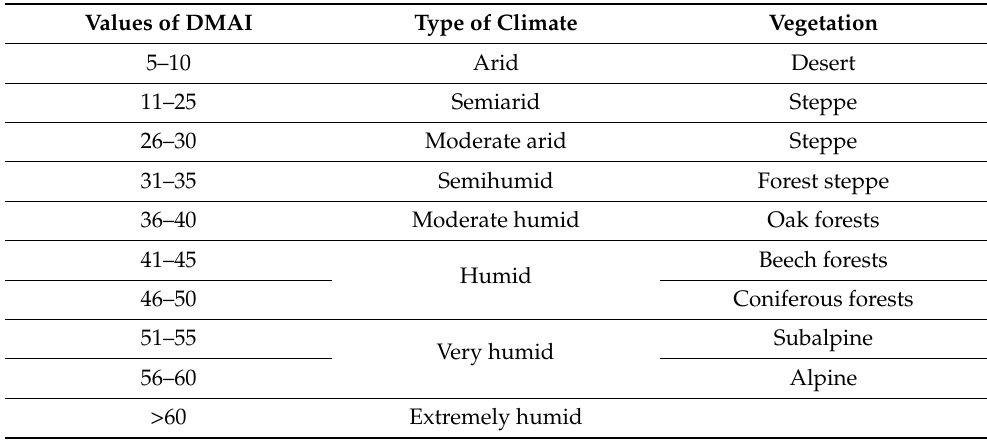
Table 1. The De Martonne aridity index classification (DMAI).